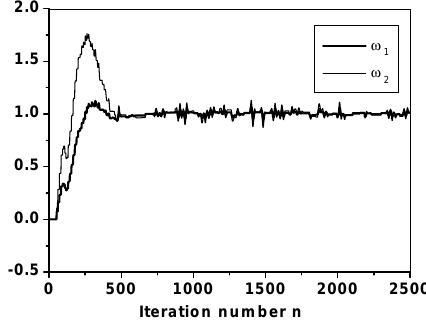
Fig. 23. Evolution of the normalized filter coefficients ( SM − BNDRLMS ), case ( C 5 ).